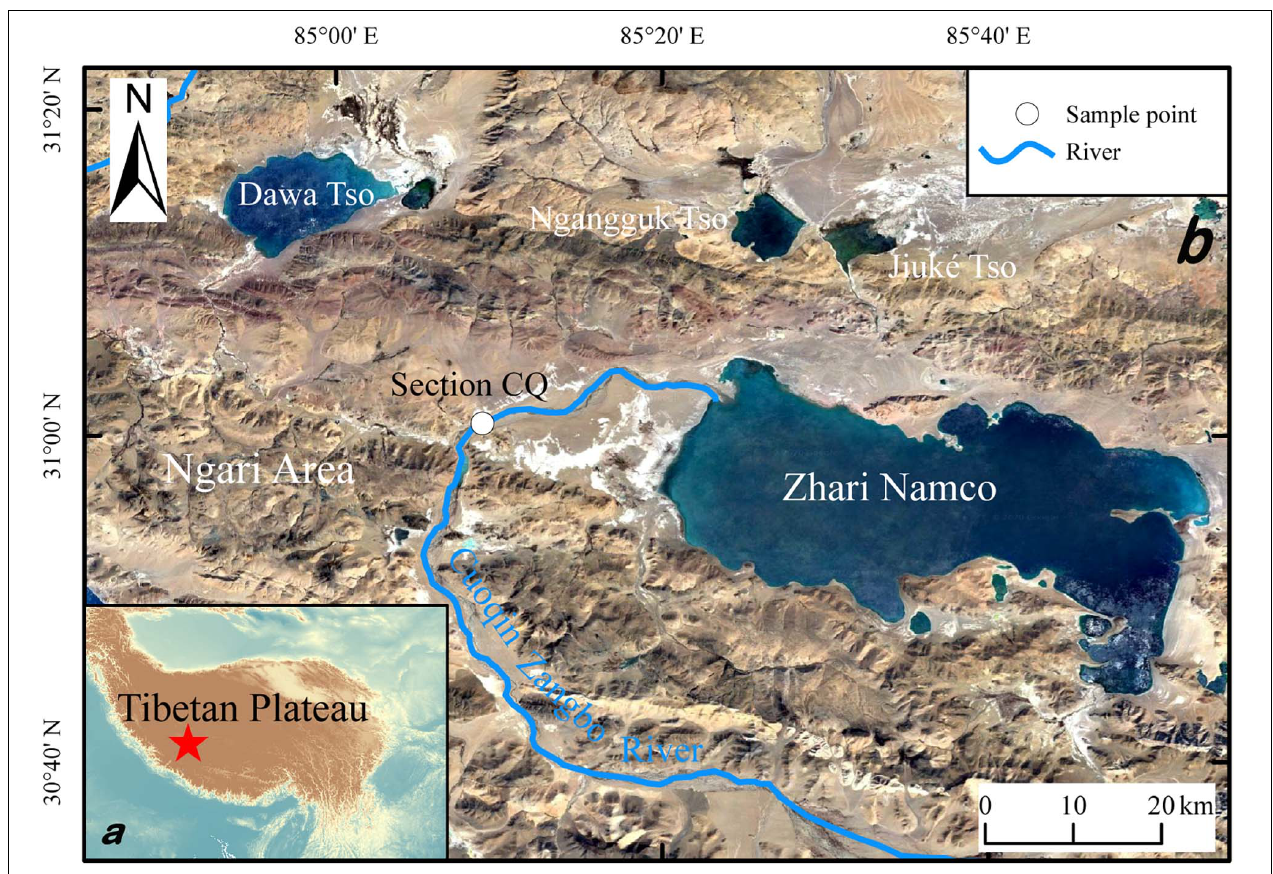
FIGURE 1 | (a) Location of Zhari Namco Lake within the Tibetan Plateau. (b) The position of section CQ (white circle) investigated in this